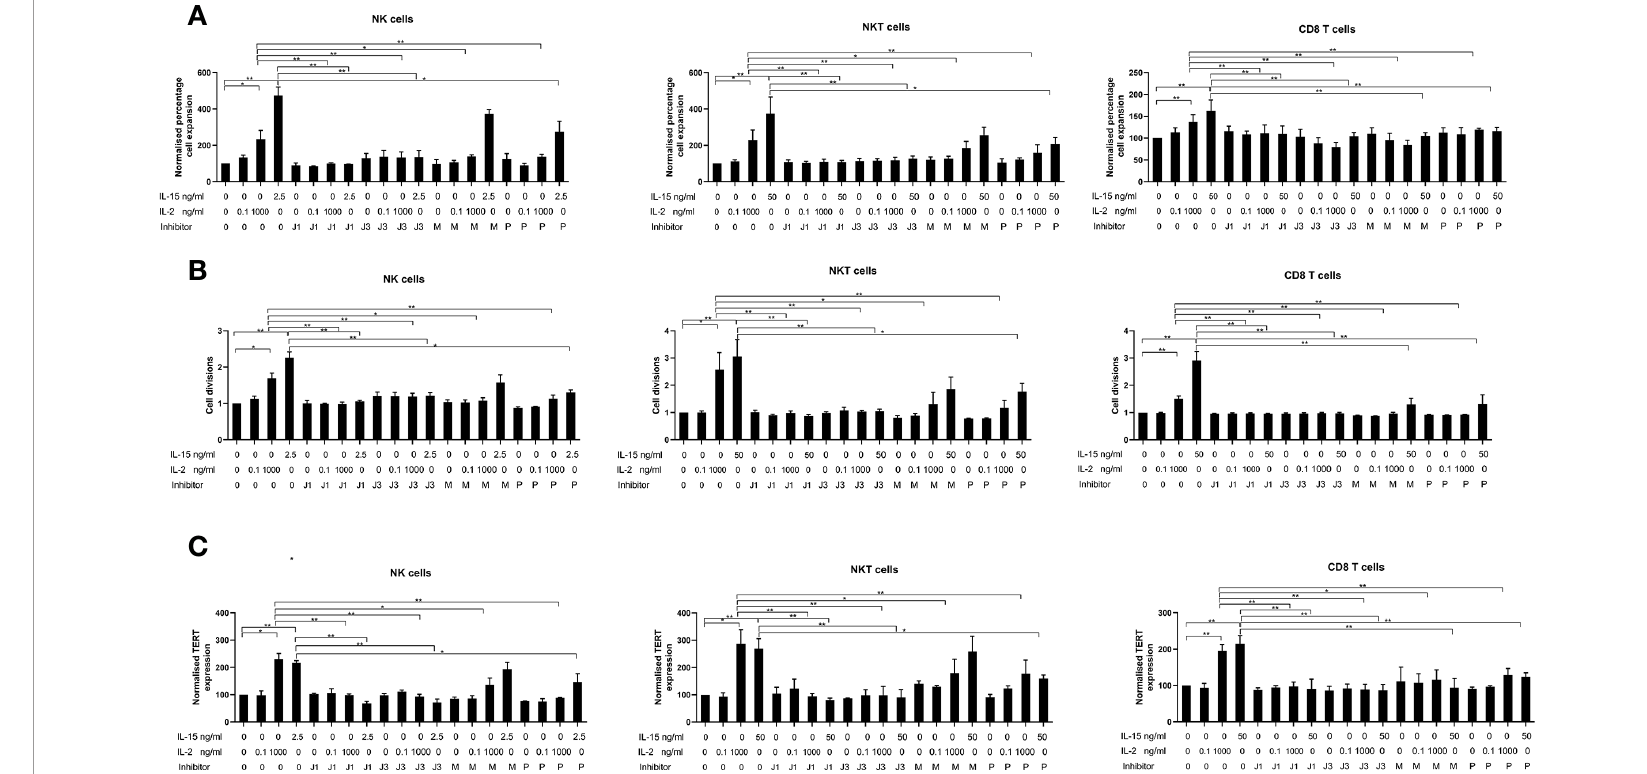
FIGURE 5 | Effects of inhibitors of JAK1, JAK3, MEK/ERK, and PI3/AKT on the upregulation of expression of TERT (A) , cell expansion (B) , and cell divisions from CFSE data (C) in NK, NKT-like and CD8 T cells. Non-adherent PBMCs were aliquoted at 8 x 10 5 cells/ml in 24-well plates together with the optimal concentrations of cytokines found to increase TERT expression for each cell type (2.5 ng/ml IL-15 and 1000 ng/ml IL-2 for NK cells, 25 ng/ml IL-15 and 1000 ng/ml IL-2 for NKT-like cells and 25 ng/ml IL-15 and 1000 ng/ml IL-2 for CD8 T cells), or controls (PBS)]. Cells were incubated for 7 days either with cytokines/control only or in the presence of inhibitors of each of the three signaling pathways known to be impacted by IL-2/IL-15 [CP690550 for JAK1 (J1) and JAK3 (J3) inhibition dependent on concentration, LY-294002 hydrochloride (P) for PI3K/AKT inhibition and U0126 (M) for inhibition of MEK/ERK]. Results are expressed as the normalized geometric mean expressions of TERT, normalized cell expansion, and normalized numbers of cell divisions and are the means +/- SEM from six separate experiments. The comparisons are between the each of the no inhibitor conditions (PBS, low IL-2, high IL-2 and IL-15) and the corresponding condition with each of the inhibitors. (*p < 0.05, **p < 0.01 by one-way ANOVA and Newman Keuls post-hoc